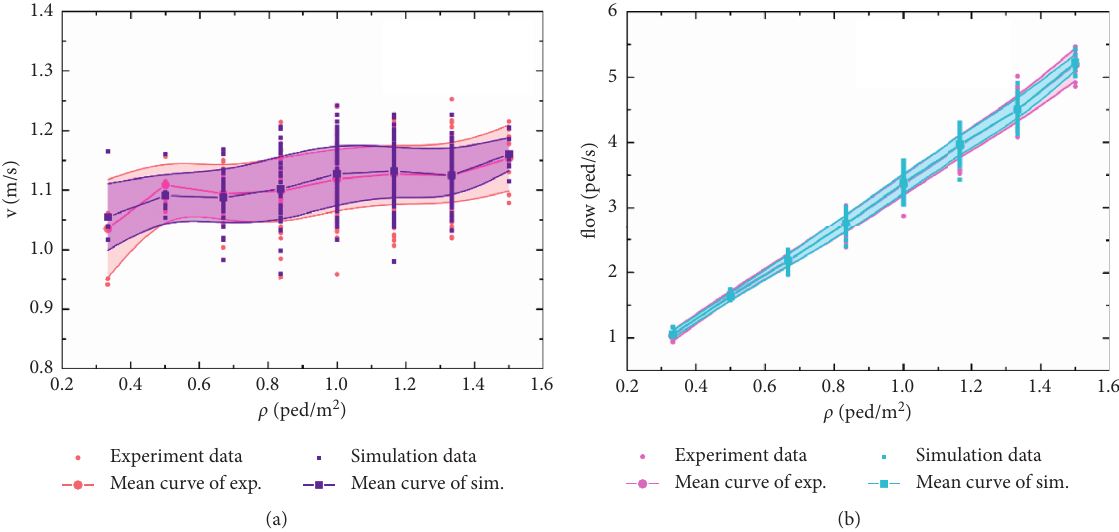
Figure 13: Comparison on density-velocity and density-flow relationships between simulated results and empirical data in the unidi- rectional flow scenario. (a) Density-velocity relationship. (b) Density-flow